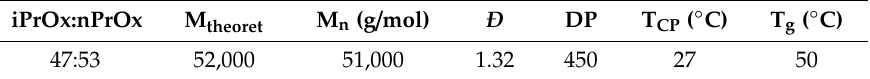
Table 1. Characteristics of the P(iPrOx-nPrOx) copolymer.